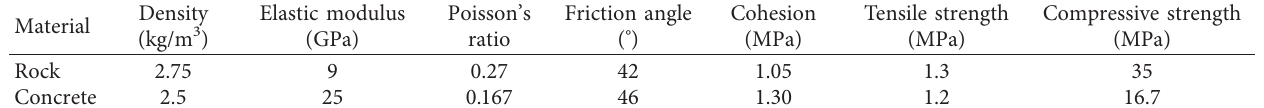
Table 1: Geomechanical properties of the materials used in the numerical solutions.